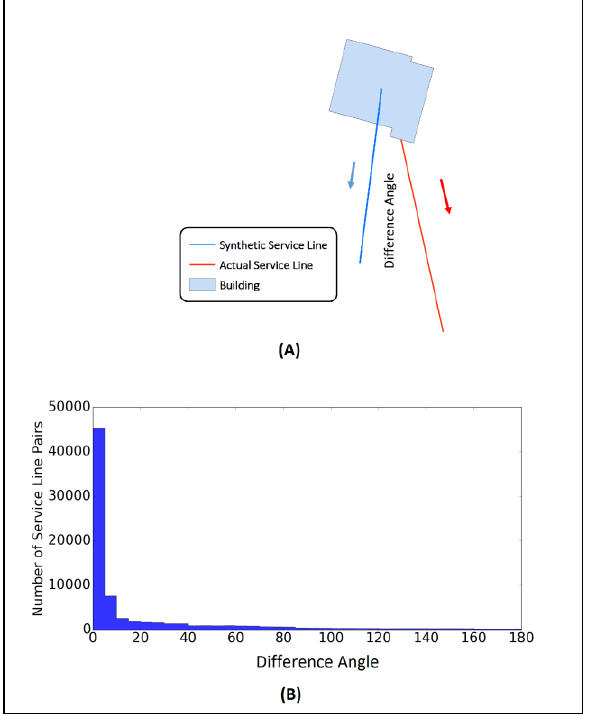
Figure 13. Validating service lines using difference angle. (A) Definition of difference angle. (B) Difference angles across